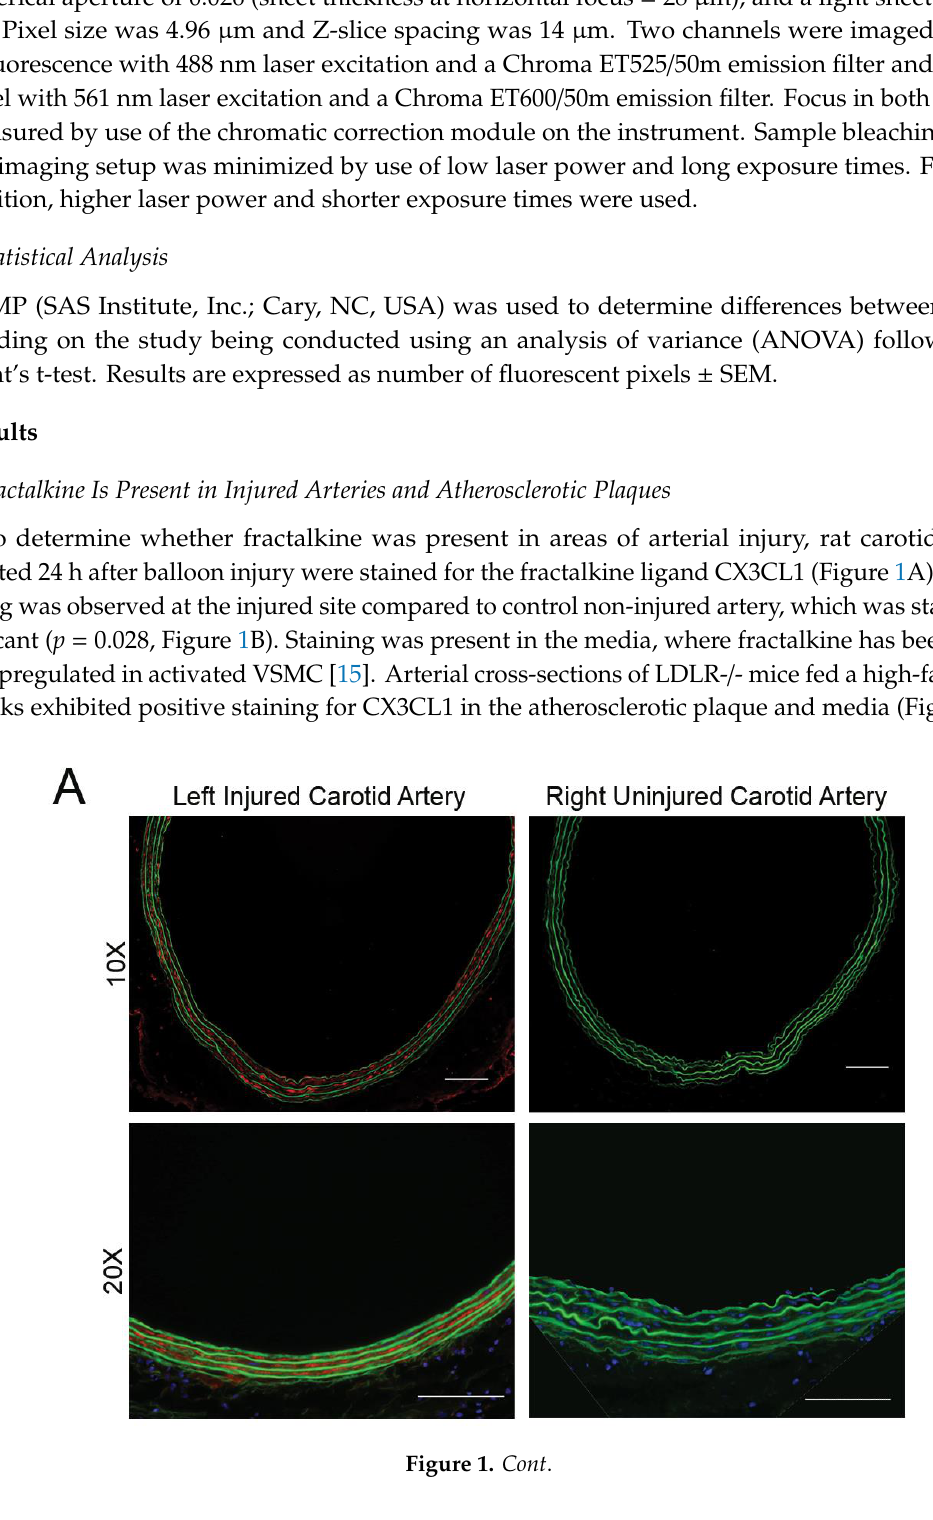
Figure 1. Immunofluorescent staining of fractalkine is present in left injured carotid artery with no fluorescent staining in the control uninjured right carotid artery. ( A ) Fluorescent microscopy of left injured and right uninjured carotid artery stained for CX3CL1. Green = autofluorescence of arterial lamina and red = CX3CL1 staining. Magnification, 20  ; n = 3/treatment group; scale bar = 100 µm. ( B ) Quantification of fluorescence demonstrates the elevated expression of fractalkine in the injured artery compared to control uninjured artery, * p < 0.05. 3.2. Targeted and Non-Targeted PAs Form Nanofibers To identify a unique targeting epitope that is present in both the atherosclerotic niche and neointimal hyperplasia, we reviewed the literature and found a peptide sequence that mimics a fragment of CX3CR1, the fractalkine receptor [21]. We chose one fractalkine-targeted sequence